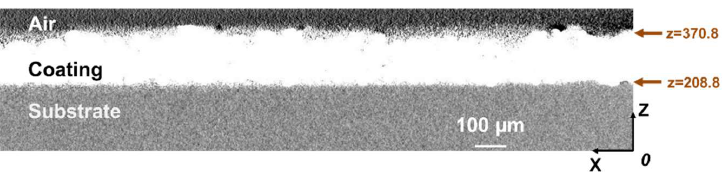
Figure 4. Reconstructed cross-section of cold sprayed SS 316L coating by tomogram image corresponding to 2D slices of the y -axis stacking.